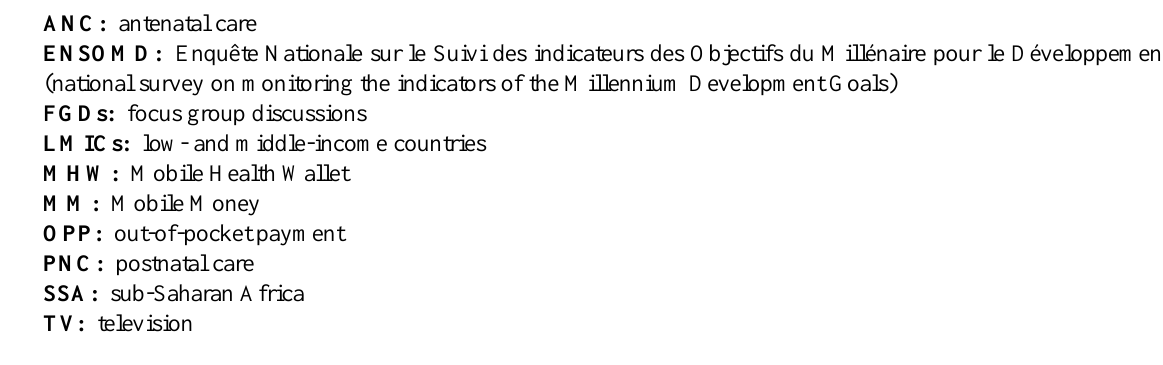
ENSOMD: Enquête Nationale sur le Suivi des indicateurs des Objectifs du Millénaire pour le Développement (national survey on monitoring the indicators of the Millennium Development